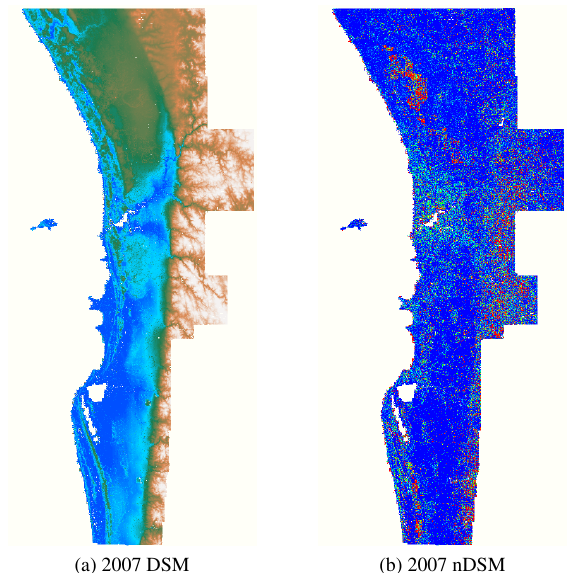
Figure 2. The UM region. It is 210 km from North to South. Viewed at this scale the DSM (a) is indistinguishable from the DTM, instead we show the nDSM (b). In the nDSM cool colours correspond to low elevations, hot colours are high elevations (red = taller than 10 m ). Noticeable are tall canopies of dense plan- tation forests in the North, and non-uniform canopy of native forests in the East. Some height errors in water are also visi- ble due to DSM issues over water. In (a) elevations range from 0 m (blue) to approximately 0 . 5 km (white) above sea level.